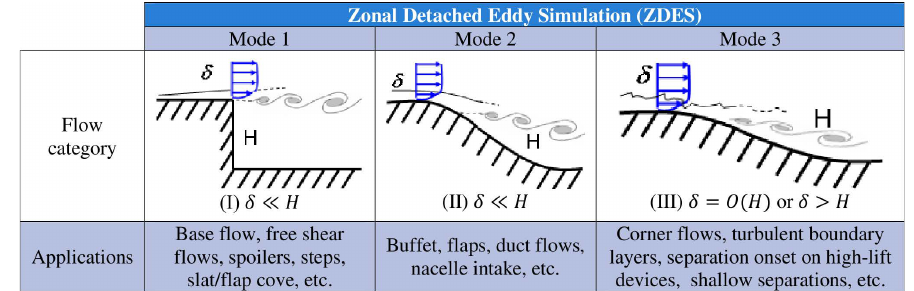
Figure 4. Classification of typical flow problems. I: separation fixed by the geometry, II: separation induced by a pressure gradient on a curved surface, III: separation strongly influenced by the dynamics of the incoming boundary layer (adapted from Deck